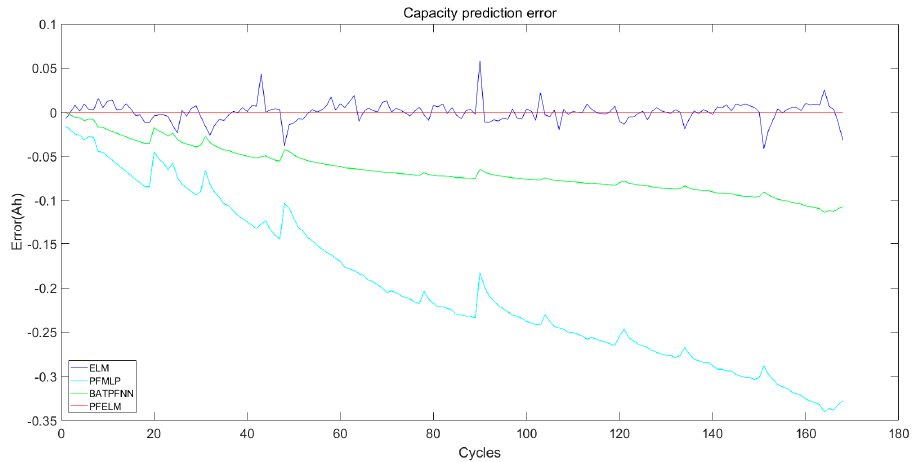
Figure 11. Capacity prediction error from the first cycle.